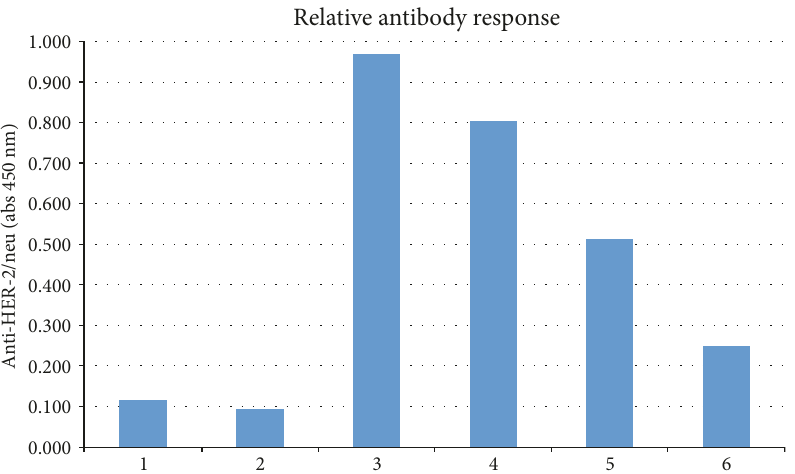
Figure 2: Appearance of representative mice from the J-HER prevention trial described in Figure 1. TUBO cell tumor development is shown for the control and J-HER-immunized mice on day 49 after tumor challenge.